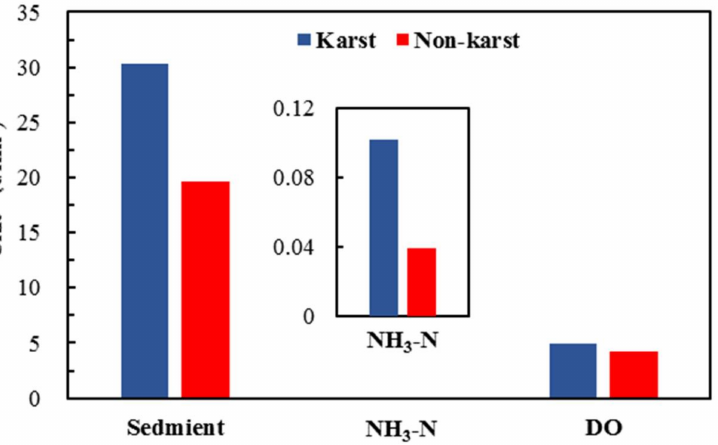
Figure 8. Diagram of the difference in annual average pollution load between the karst and non-karst